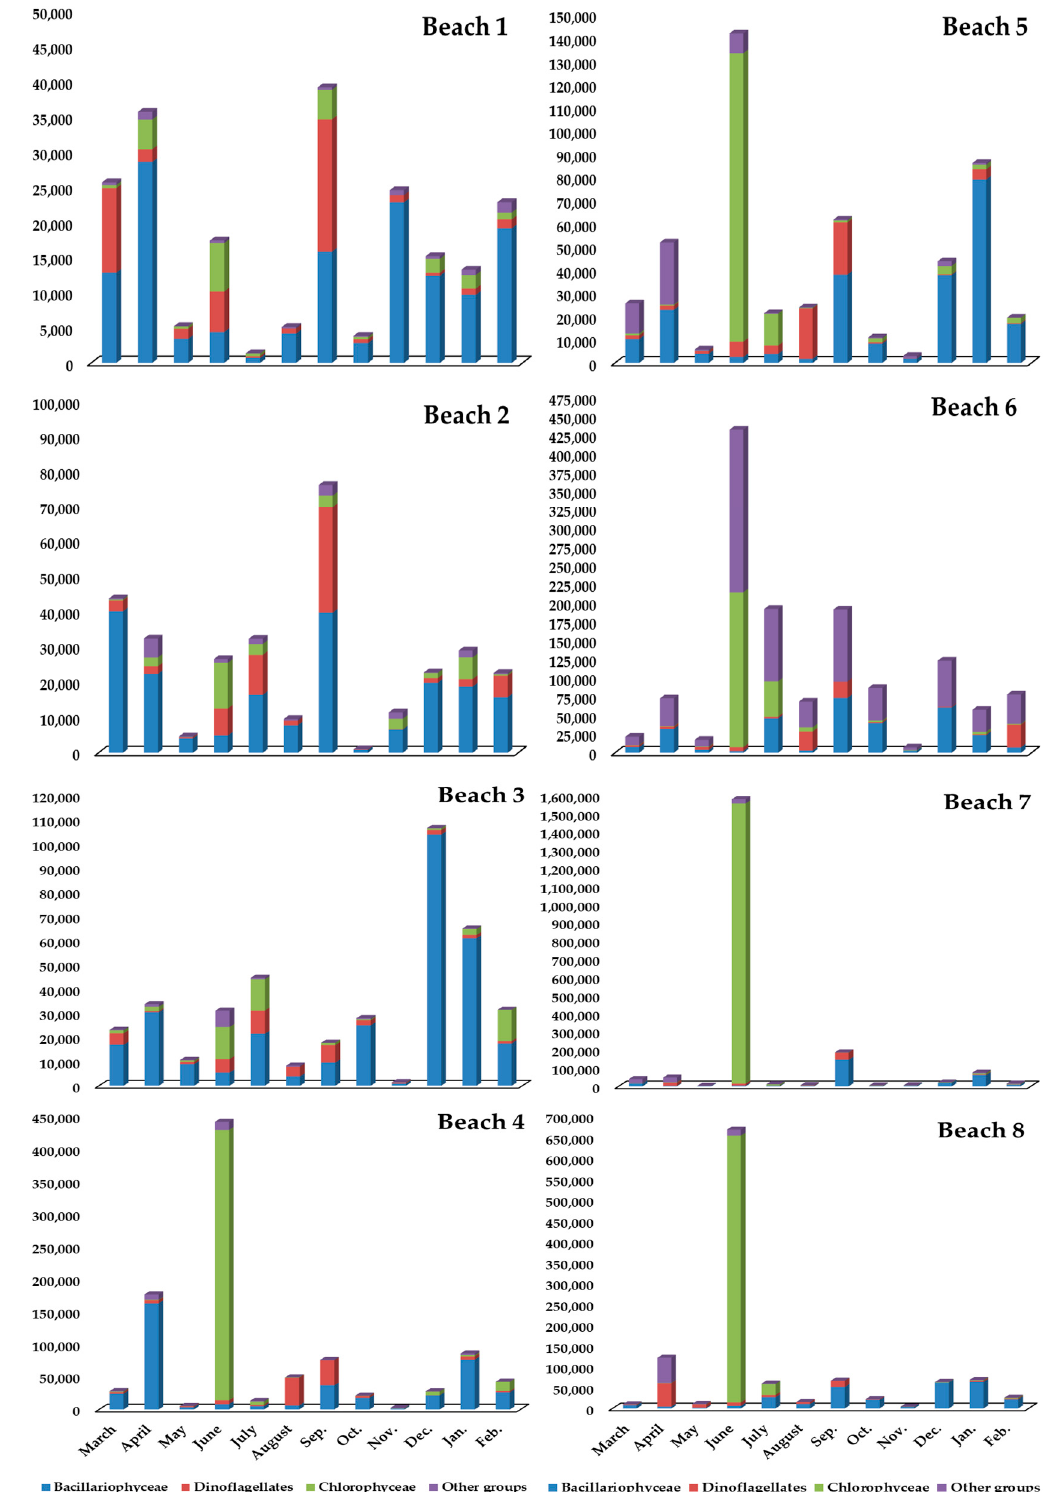
Figure 2. Monthly phytoplankton abundances among eight Alexandria beach sites sampled from March 2019 through